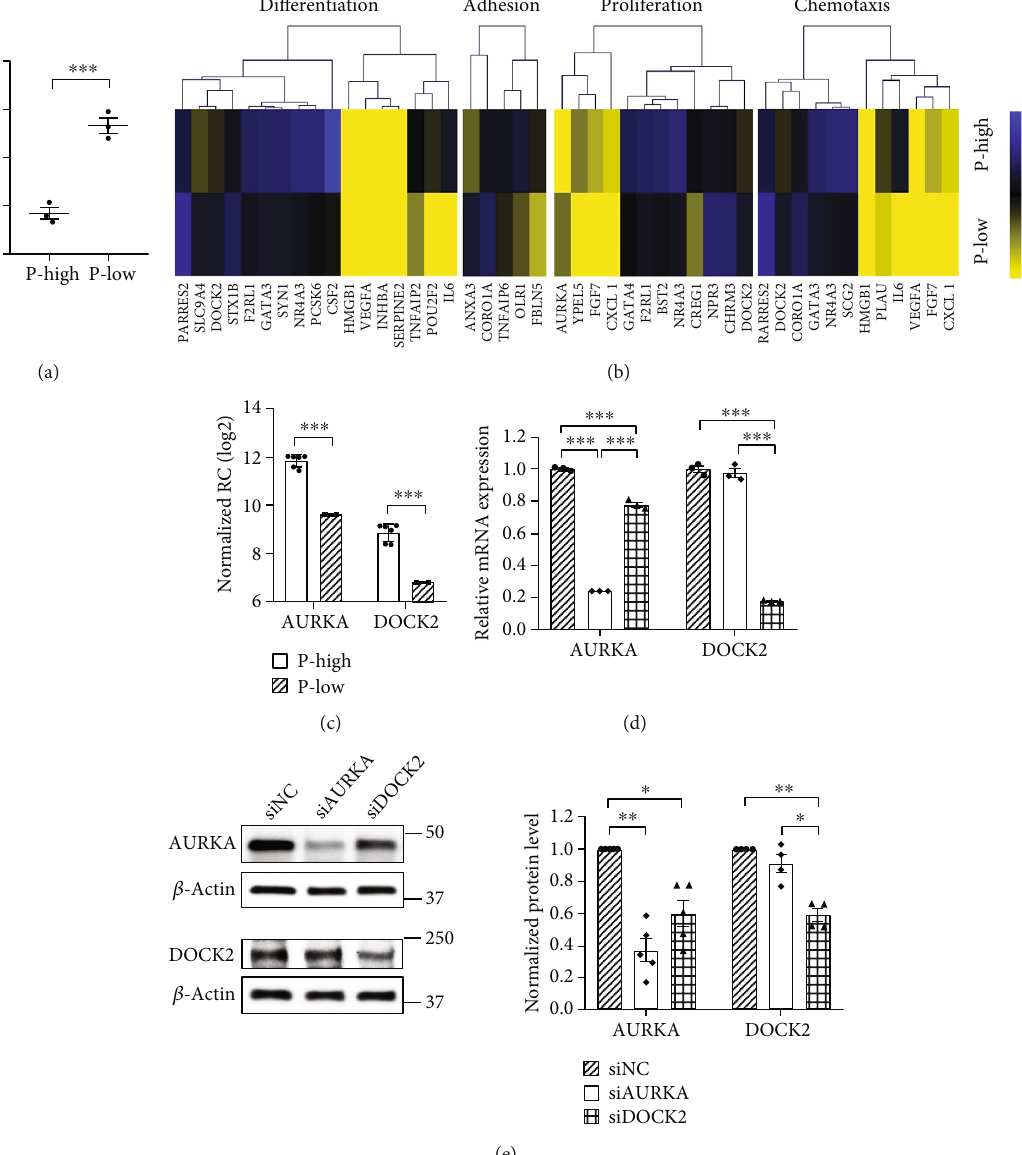
Figure 1: Comparative analysis of gene expression pro fi les of WJ-MSCs according to their proliferative capacity. (a) Doubling time of WJ- MSCs was measured, and the cells were classi fi ed into the proliferation-high (P-high) and proliferation-low (P-low) groups. (b) Heat map shows 33 di ff erentially expressed genes related to cell di ff erentiation, secretion, cell proliferation, cell adhesion, chemotaxis, and cell growth in both groups. (c) AURKA and DOCK2 genes expressed more signi fi cantly in the P-high group than in the P-low group. DEG selection criteria: signi fi cant fold changes ( p < 0 : 05 ), fold change > 3 , normalized read count ð RC Þ > 6 . (d) mRNA expression levels of AURKA and DOCK2 decreased at 48h after siRNA transfection. (e) Suppression of AURKA and DOCK2 expression was examined by western blotting at 72h after siRNA transfection. Normalized protein level indicates the value converted based on the siNC group. Data are shown as means ± SEM . Two-tailed Student ’ s t -test (a, c). One-way ANOVA with Tukey ’ s multiple comparisons test (d, e). ∗∗∗ p < 0 : 001 , ∗∗ p < 0 : 01 , and ∗ p < 0 : 05